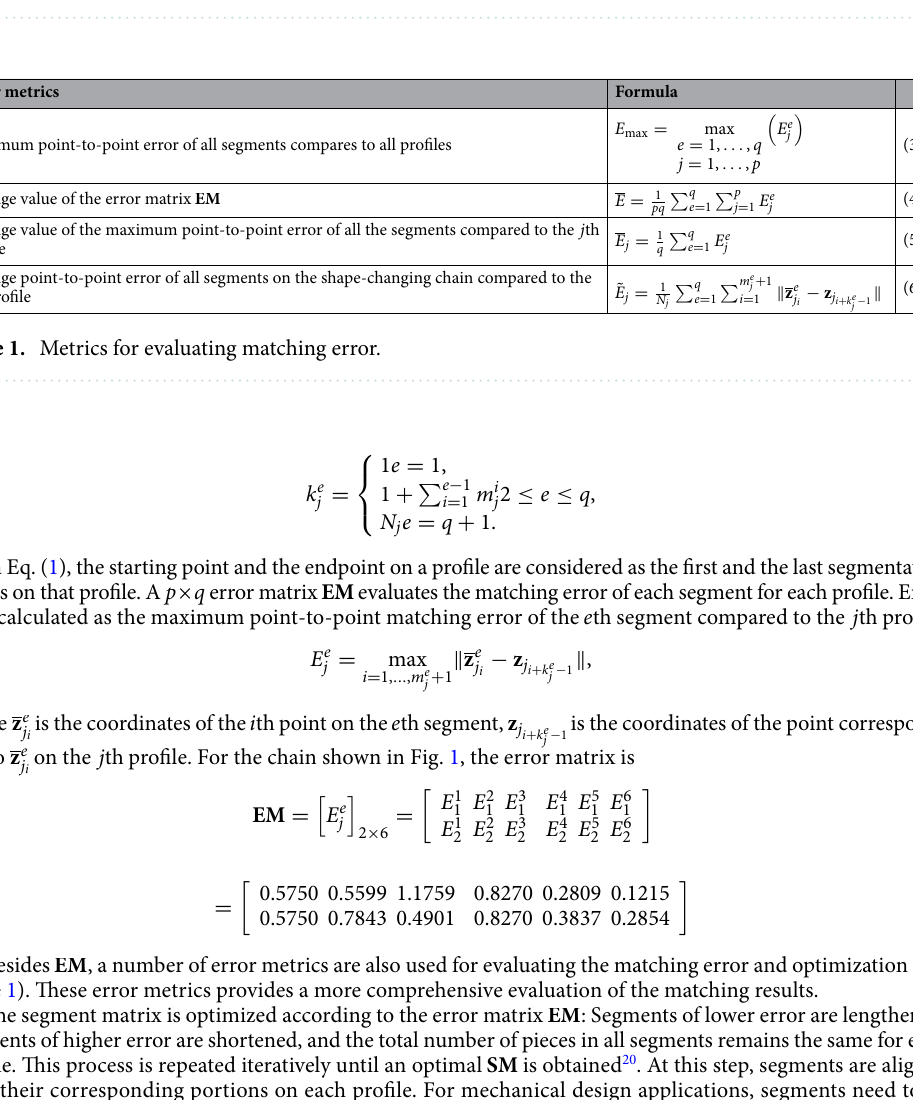
Figure 1. Two 2D profiles are matched by a single shape-changing chain.